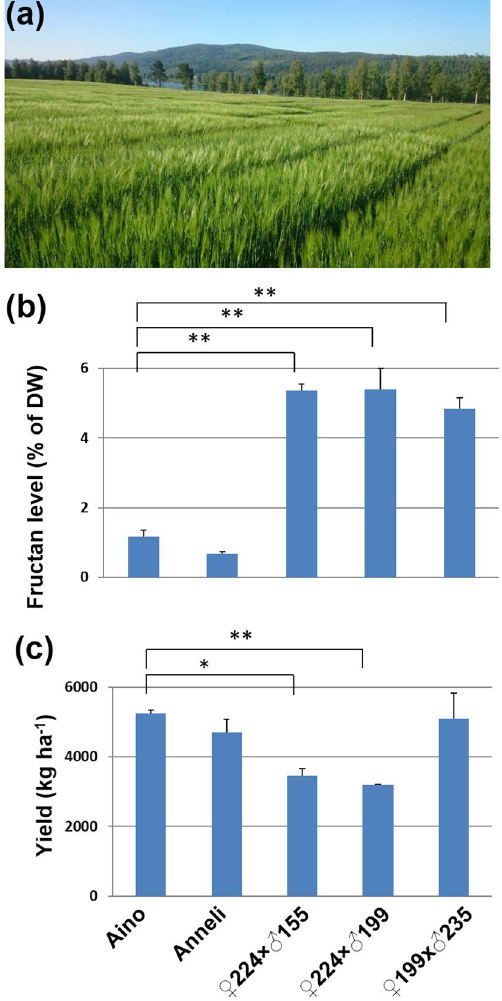
Figure 6. A large field trial to assess fructan levels and yield. ( a ) Photo of a large field trial. ( b ) Fructan content in the field trial samples. ( c ) Yield of two elite varieties, Aino (6 row) and Anneli (2 row), and F 5 crosslines of high grain fructan barley. Student’s t-test was used (Error bars show SD). * P < 0.05 and ** P < 0.01 are shown for significant differences between high-fructan barley and elite varieties. Plot of 15 m 2 for each line and two plots were performed following the agricultural company´s test system. Three biological replicates or grains from three independent plants ( n = 3) were used for fructan